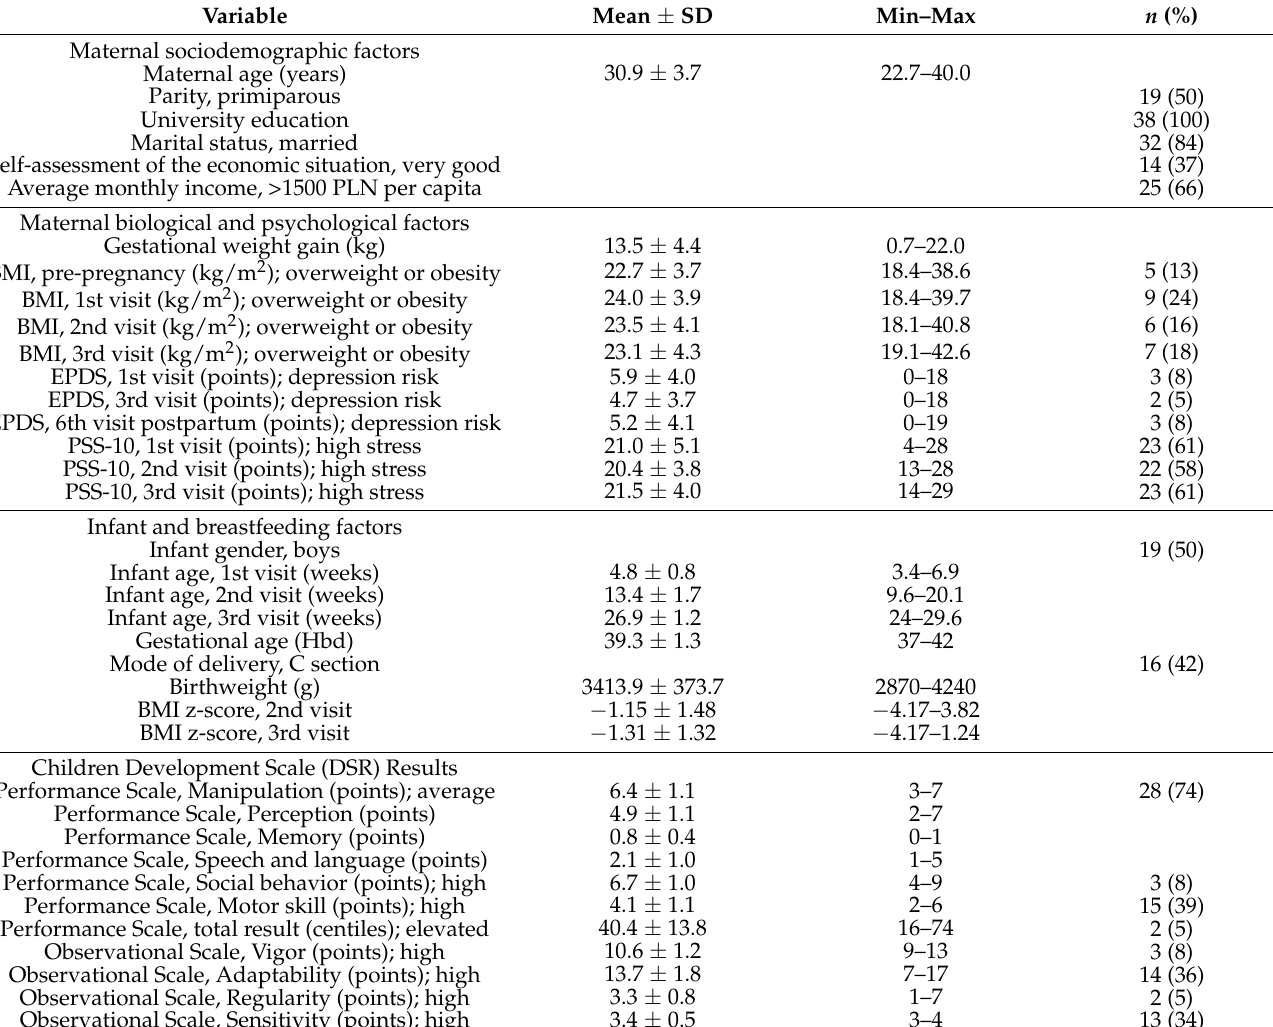
Table 1. Characteristics of mother–infant pairs participating in the